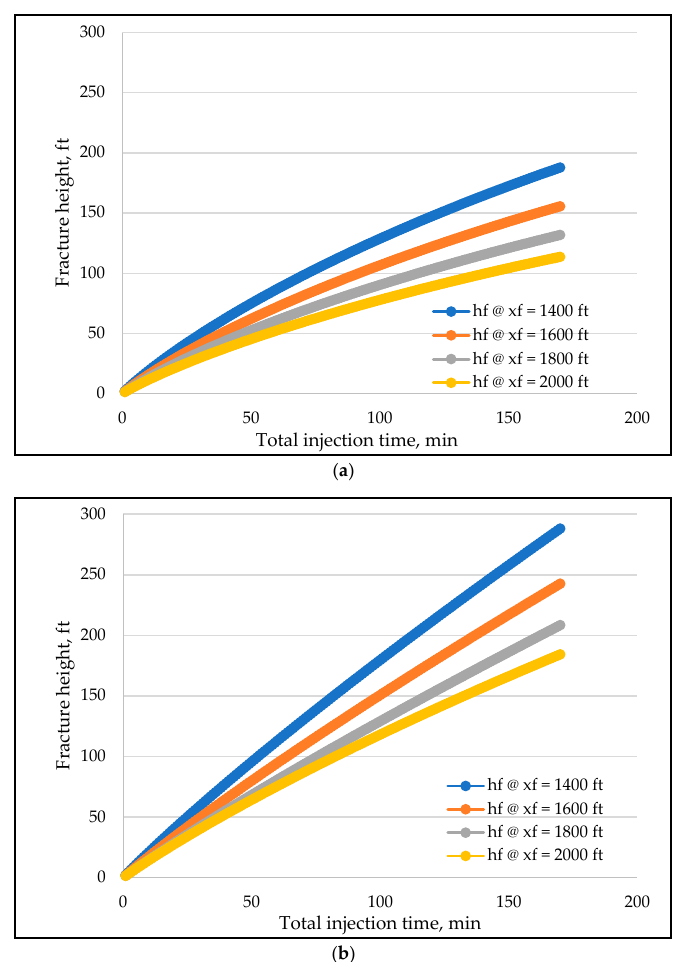
Figure 10. ( a ) Impact of fracture half-length variation on fracture height versus total injection time for the P3D-C model; ( b ) impact of fracture half-length variation on fracture height versus total injection time for the P3D-C-DP model.